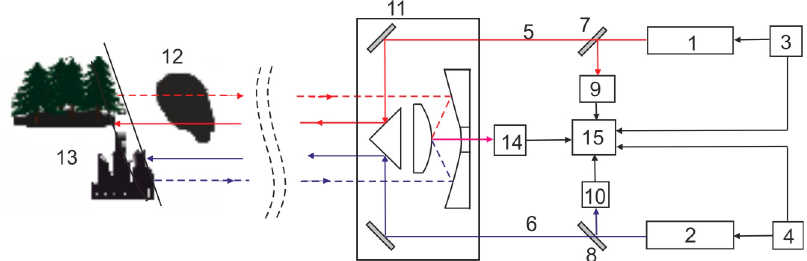
Figure 12. The diagram of the DIAL measuring system and its view.